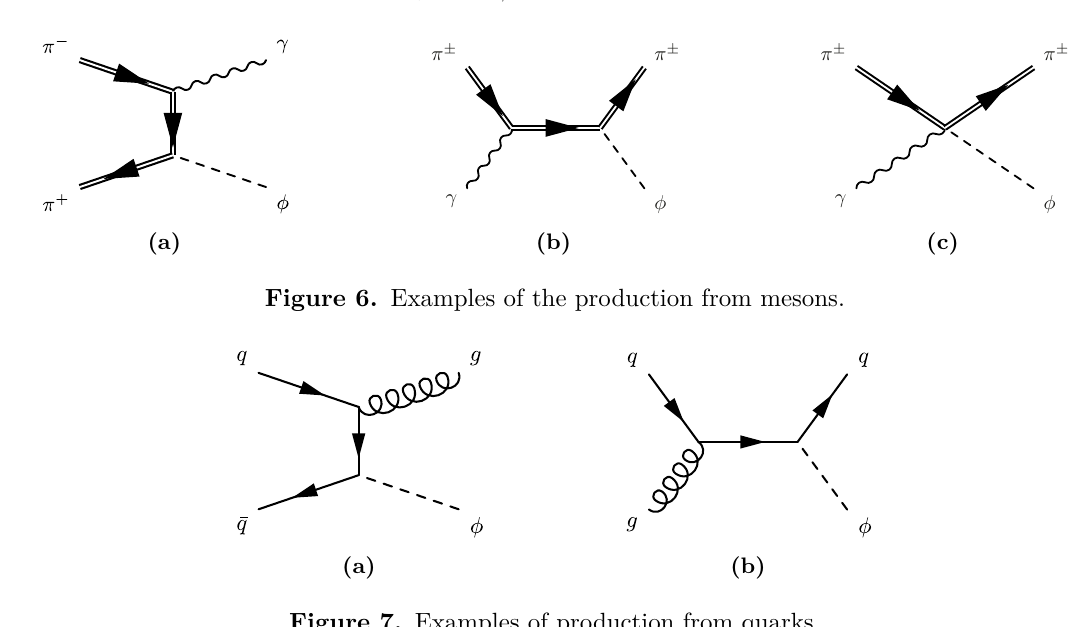
Figure 5. Examples of the production from leptons for m φ < 2 m µ . The inverse decay from the electron positron pair is effective only for m φ > 2 m e .